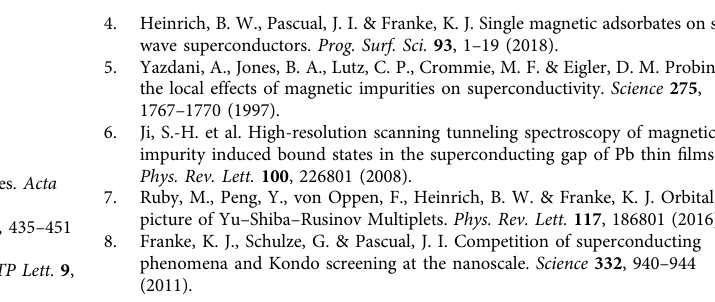
= 0.2 meV and t = d d